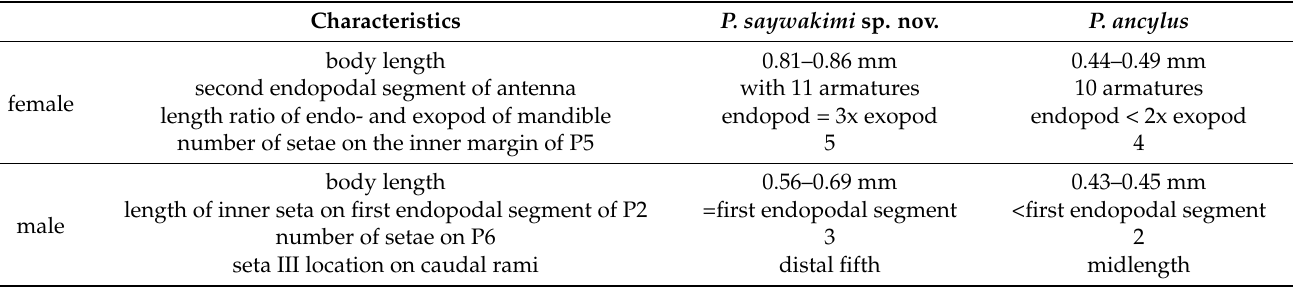
Table 1. Morphological comparison of Phyllopodopsyllus saywakimi sp. nov. and P. ancylus .